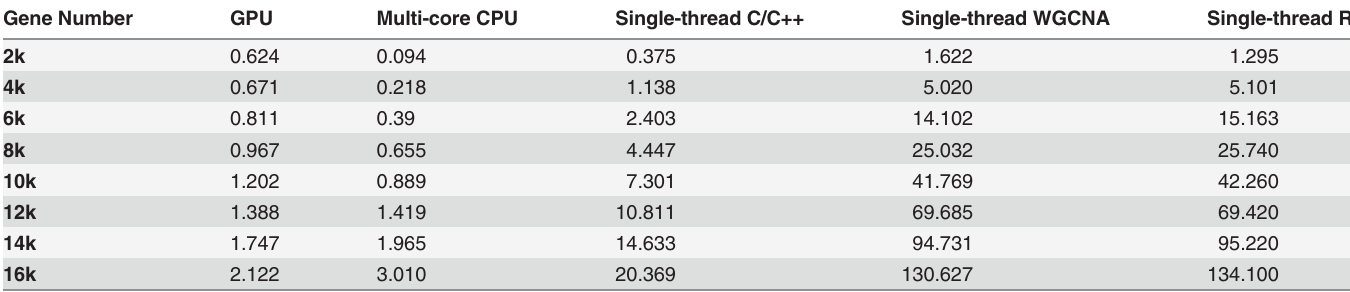
Table 1. Running time (in seconds) for the GPU implementation, Multi-core CPU implementation, Single-thread C/C++ implementation and Single-thread R implementation when 50% of the genes were fi ltered out during the data preprocessing stage (individual number = 590).